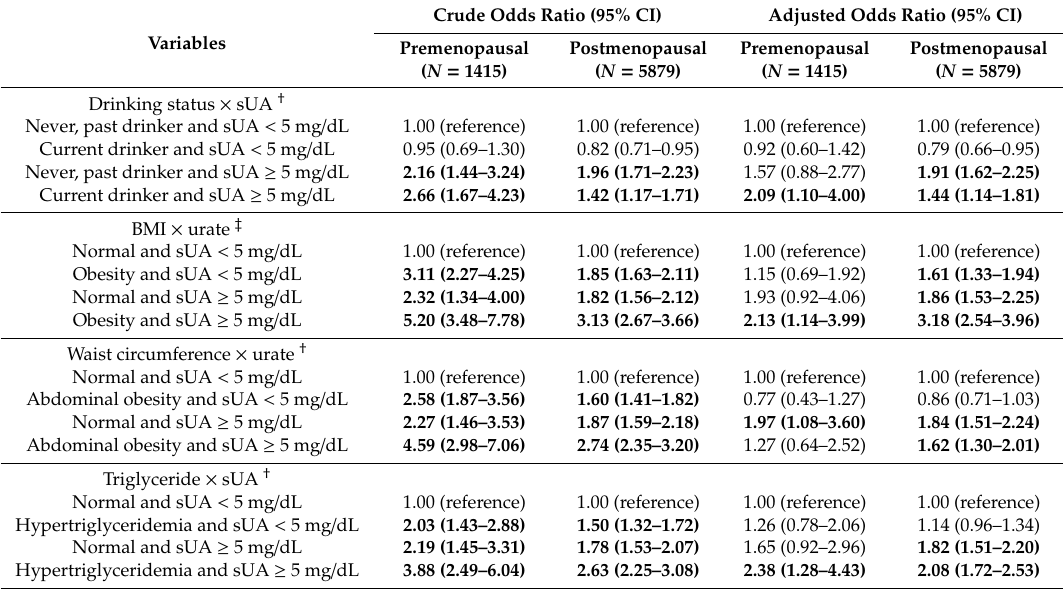
Table 3. E ff ect of interactions between anthropometric parameters on hypertension in premenopausal and postmenopausal women.